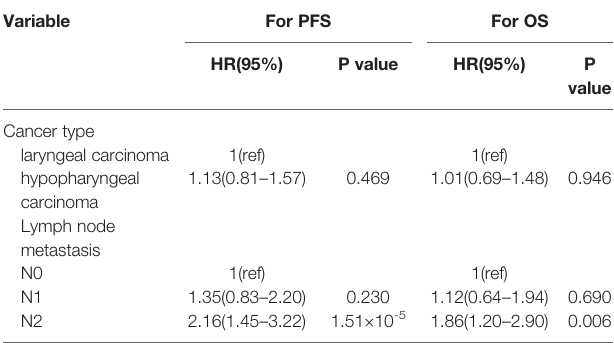
TABLE 4 | Multivariable analysis of prognostic factors for patient